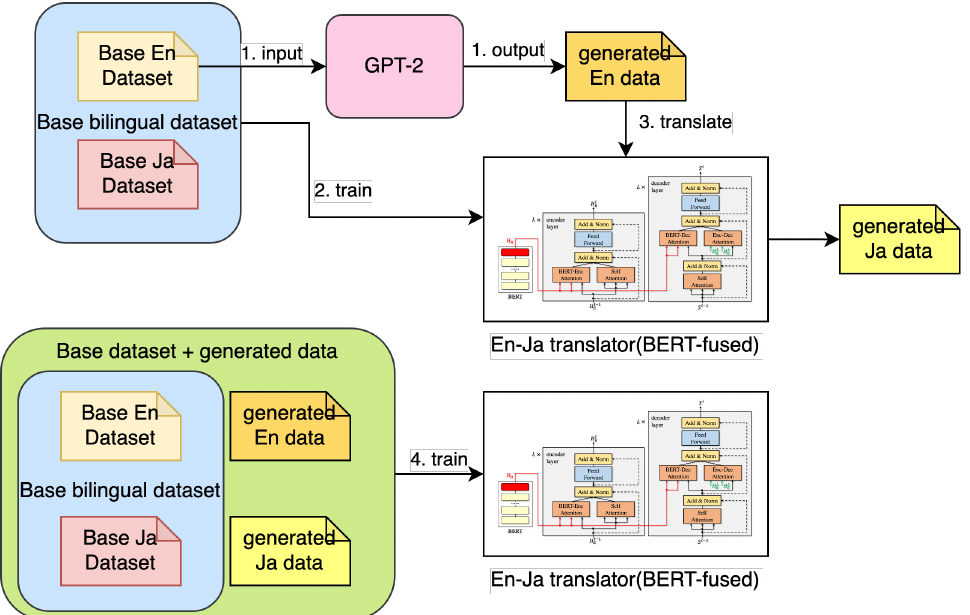
Figure 6. This figure describes how to increase the data and which data to use to train the